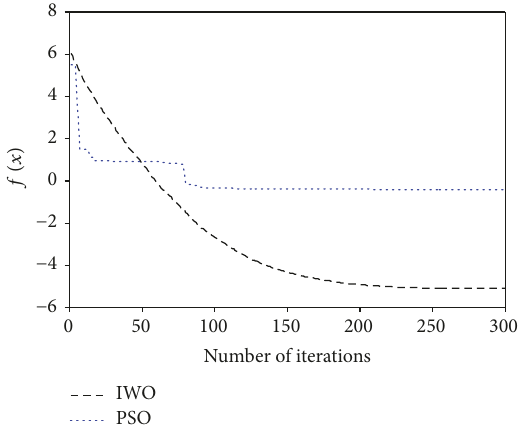
Figure 6: Diagram of iterative curves.